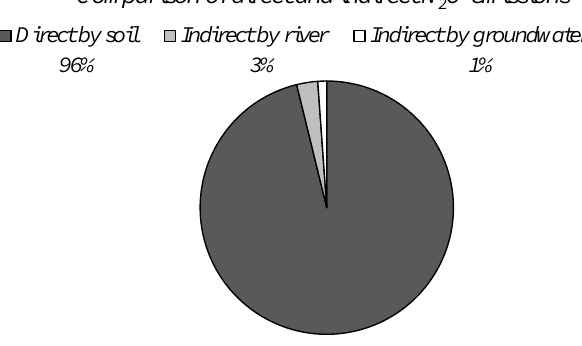
Fig. 7. Comparison of direct and indirect N 2 O emissions at the Orgeval basin scale, based on the “Topo index × (MOS + ECO- MOS)”